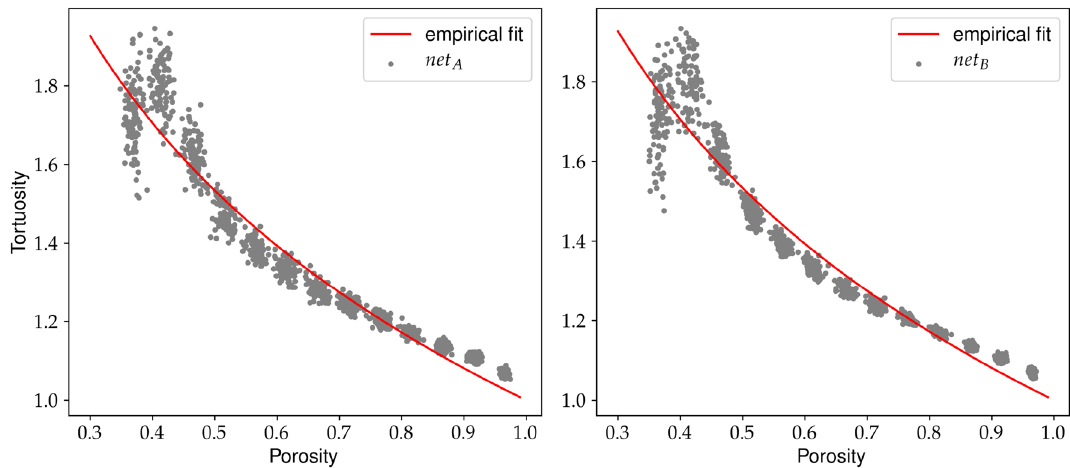
1 0.77 log (ϕ) obtained = −